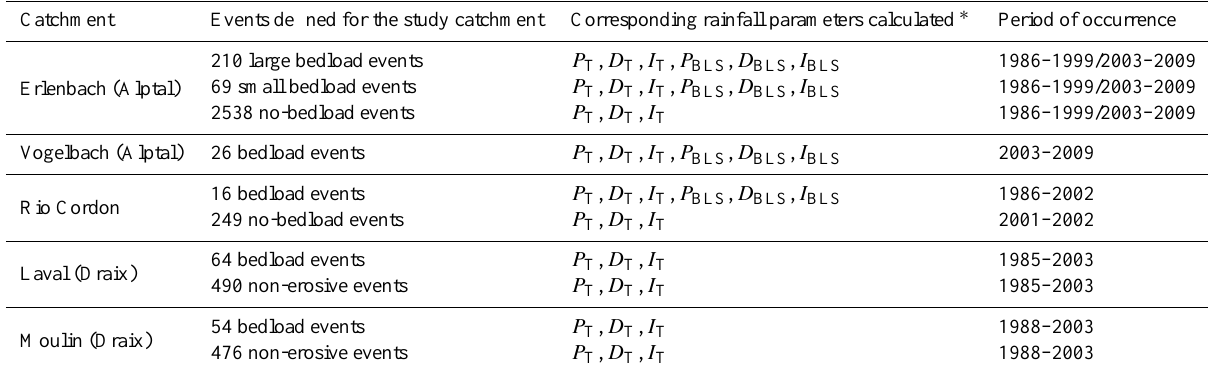
Table 3. Description of events considered in this